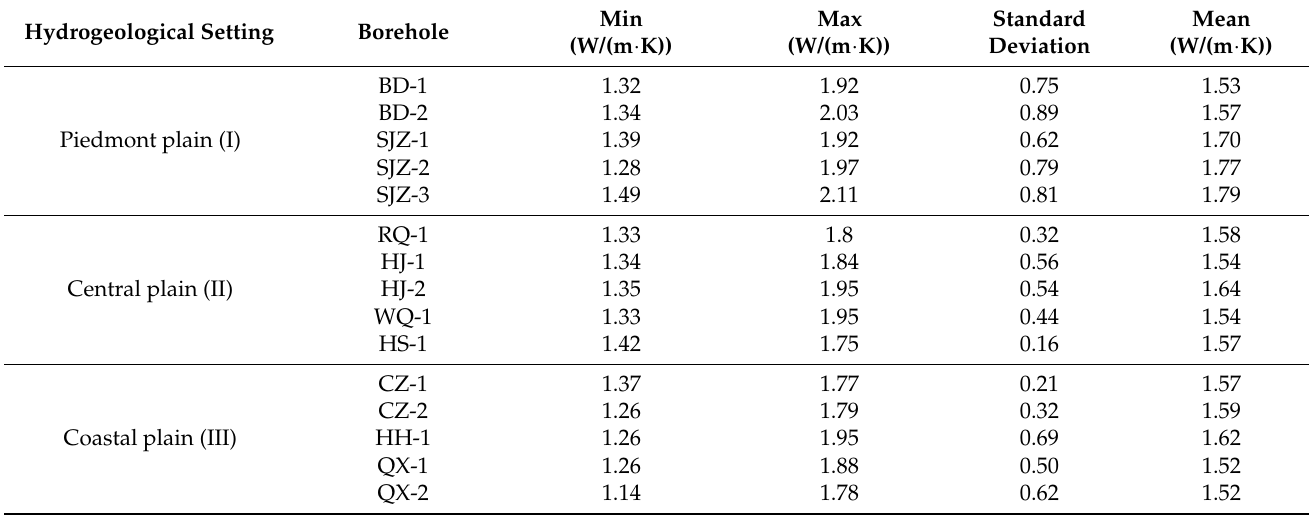
Table 5. Deviation of laboratory measurements of thermal conductivity in boreholes.